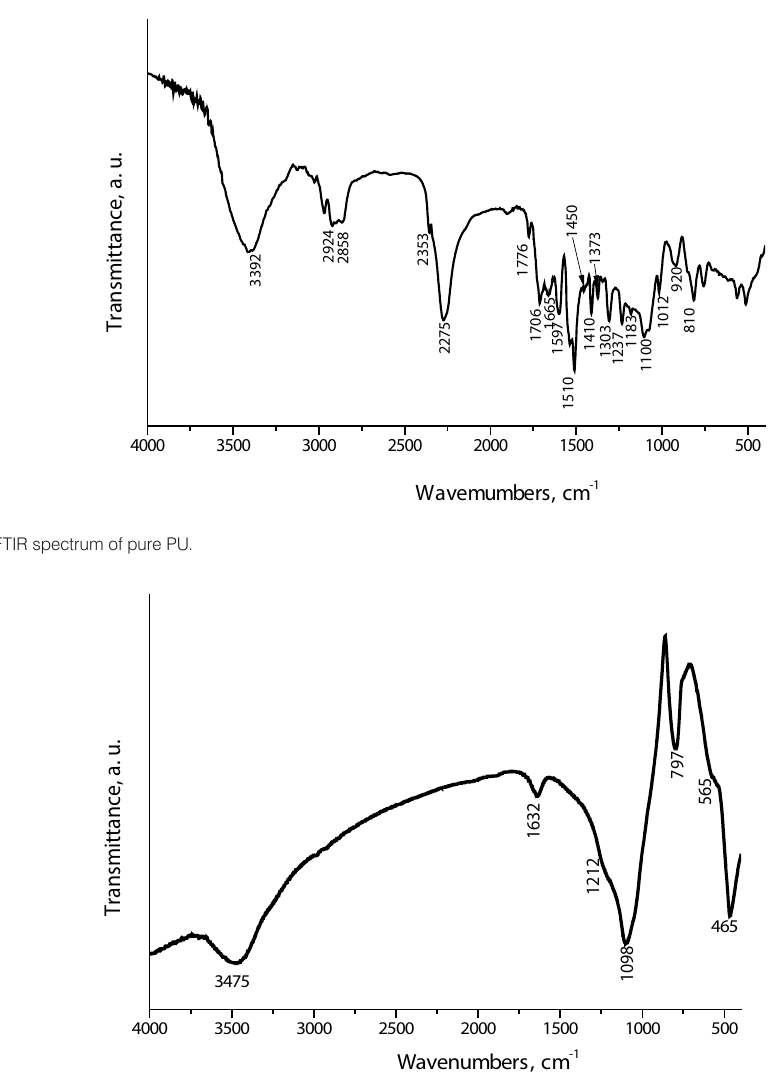
Figure 3. FTIR spectrum of pure 85S bioactive